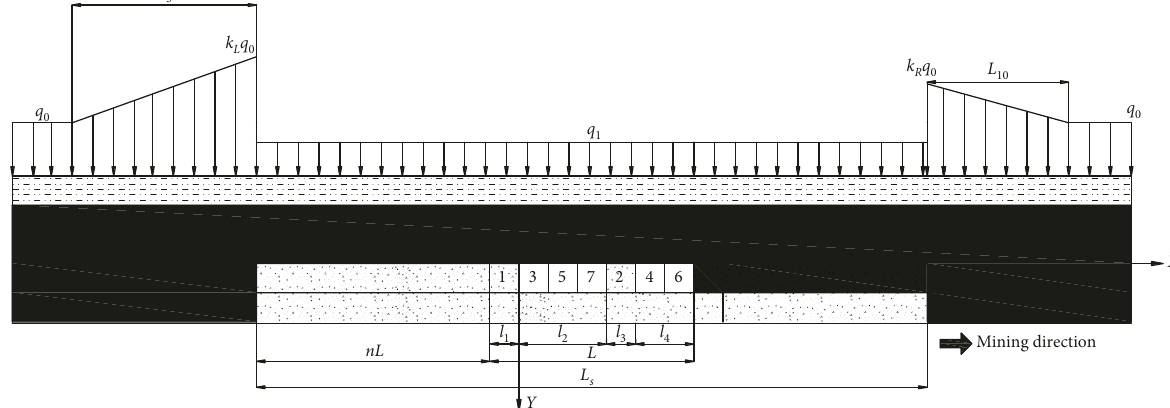
Figure 4: Foundation structure of mining the remaining upper slices.